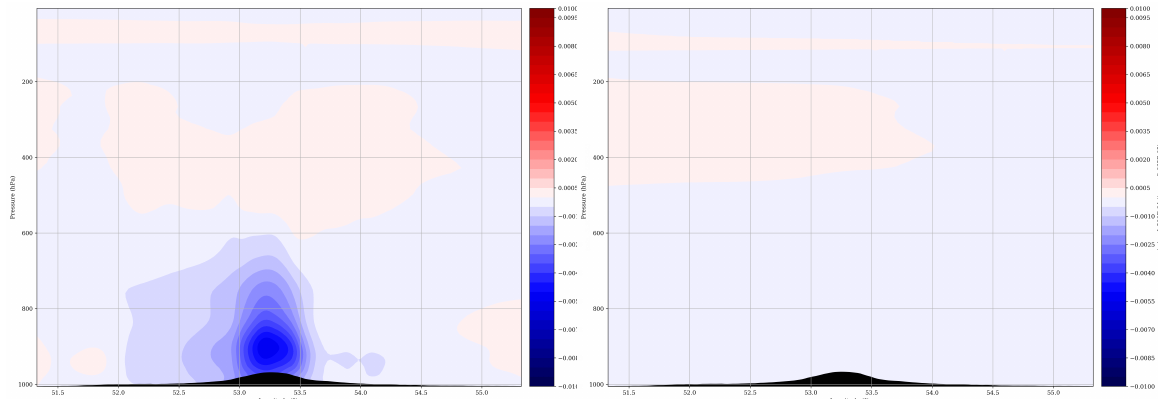
Figure 12. Specific humidity analysis increment on zonal section (51°3 E–55°3 E, 12°2 S) across TC center on 7 February 2019 02:00Z for SAR_12km_2ms ( left ) and NO_SAR ( right ).